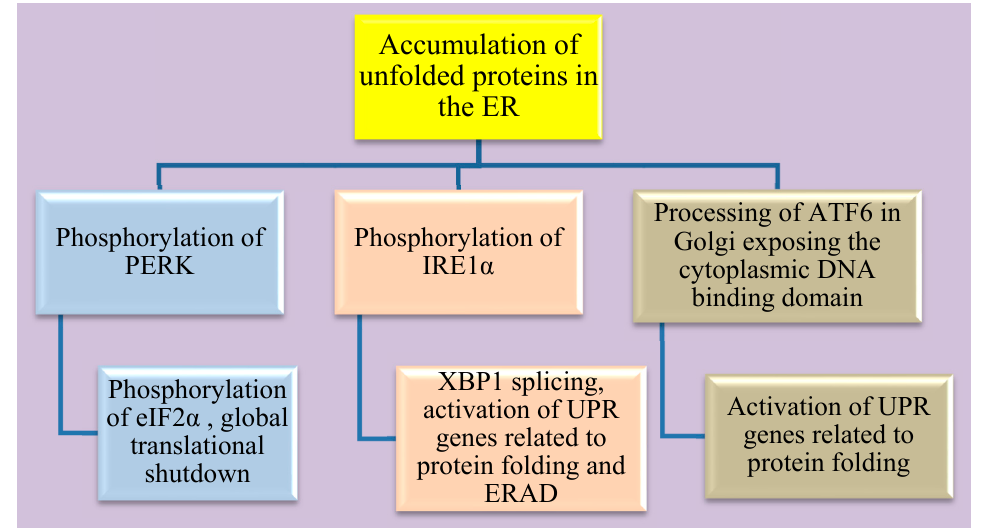
Figure 2. Schematic representation of the three arms of ER stress and its downstream targets. Flaviviruses are closely associated with ER stress as they replicate within the cellular membrane-bound organelles especially the ER. Accumulation of structural and non-structural proteins in the ER results in the formation of convoluted spherules which activate UPR. Apart from this, ZIKV also remodels the ER in terms of its protein and lipid content [194,195]. The shift from direct to indirect neurogenesis is carried out by decreasing UPR activity. Any dysregulation in this response could lead to microcephaly. ZIKV infection in neuronal progenitor cells activates PERK and IRE1 α signaling pathways, suggesting the molecular mechanism behind the cause of microcephaly [196]. Further, ZIKV could indirectly activate UPR in response to ER stress by inducing cytokine and chemokine pro- duction in infected and non-infected neuronal cells. This also attracts the resident macro- phages (microglial cells), amplifying the response [197]. ZIKV can also thwart the UPR mechanism in cells to counteract ER stress by downregulating Bip in A549 cells (human alveolar basal epithelial cell line) [198]. Additionally, there is cross-talk between the pathways of these three arms. Activa- tion of the PERK pathway inhibits global protein synthesis via the phosphorylation of eukaryotic initiation factor 2 (eIf2 α ). ZIKV infected neuronal cells also show activation of the PERK pathway involving phosphorylation of eIf2 α and activation of other targets such as ATF4, ATF3 and CHAC1(glutathione-specific γ -glutamylcyclotransferase 1) [196,199]. Activation of IRE1 α which has endoribonuclease activity splices out a 26-nucleotide in- tron from X-box binding protein 1 (XBP1) resulting in a frameshift. This spliced XBP1 is now a transcription factor and can translocate to the nucleus for the upregulation of UPR- related genes that are involved in protein folding and endoplasmic reticulum-associated degradation pathways (ERAD) [200]. ZIKV is known to activate the IRE1 α arm including XBP1 gene splicing, ER degradation-enhancing α -mannosidase-like 1 (EDEM-1) activa- tion in neuronal cells [199]. Activation of IRE1 α and XBP1 gene-splicing facilitates lipid droplet production via stearoyl coenzyme A desaturase 1 (SCD1) [201]. ER stress also in- duces the activation of ATF6 and is translocated from the ER to the Golgi apparatus where it is processed to expose its cytoplasmic DNA binding domain. This fragment of ATF6 processed in the Golgi apparatus acts by upregulating the expression of UPR related genes that aid in protein folding [202]. ATF6 is known to positively regulate XBP1 gene expres- sion during UPR activation. Further, ATF6 pathway is activated in ZIKV infected neu- ronal cells via its nuclear translocation [199].